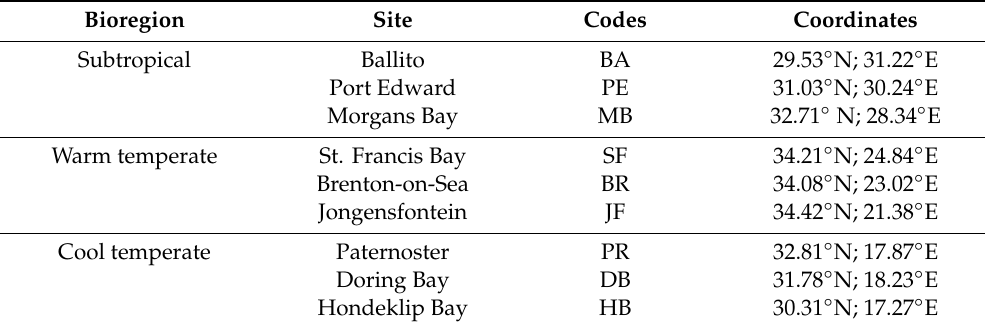
Figure 1. Overall prevalence of endolithic infestation along the cool temperate, warm temperate and subtropical bioregions of South Africa. Proportion of infested mussels (level A–E) shown in black. Full site names in Table 1. Table 1. List of study